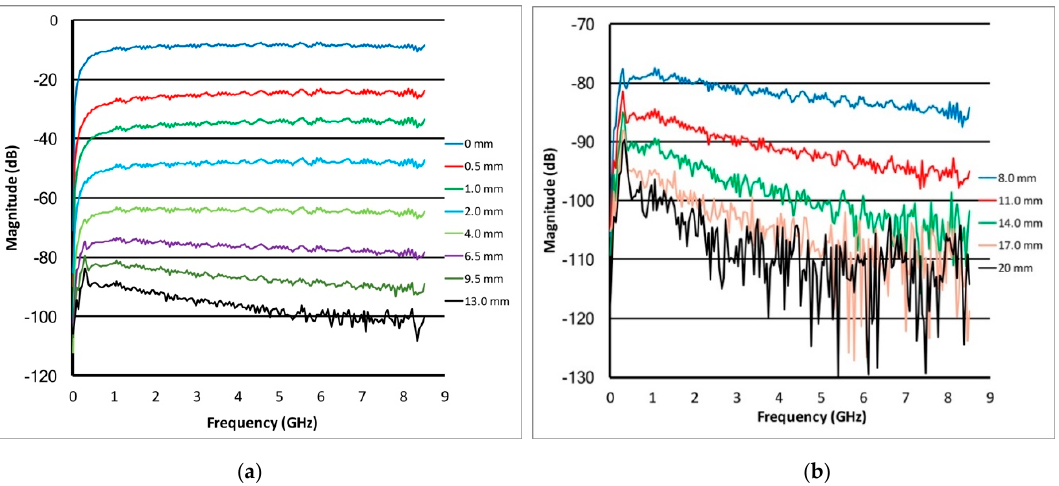
Figure 2. Magnitude plots for the transmission probes as a function of frequency for ( a ) a set of closer spacings (0–13 mm) and ( b ) a set of more distant spacings (8–20 mm), respectively, for an 80:20 glycerin:water coupling